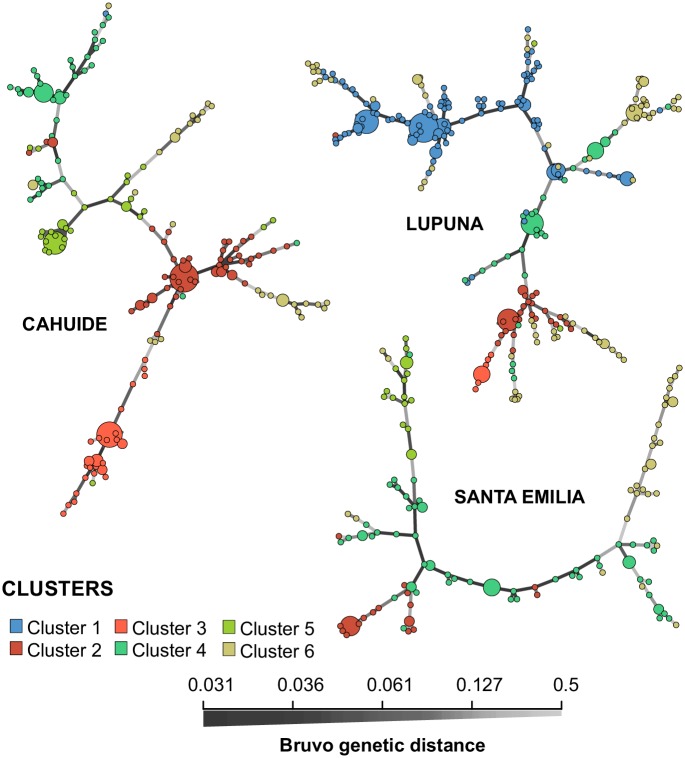
Minimum spanning network of haplotypes based on Bruvo’s distance with 16 microsatellite markers by study area.Color denotes parasite clusters according to the population structure analysis. The circle size corresponds to the number of total individuals with the same haplotype. Branch darkness is proportional to inferred genetic distance between haplotypes. MSN was inferred assuming parsimony principle. The MSN is consistent with the cluster assignation made by Structure v2.3. Samples in each cluster from CAH and LUP are distributed in a few high-frequency haplotypes, and in haplotypes closely related to the high-frequency haplotypes; which is a sign of clonal expansion.